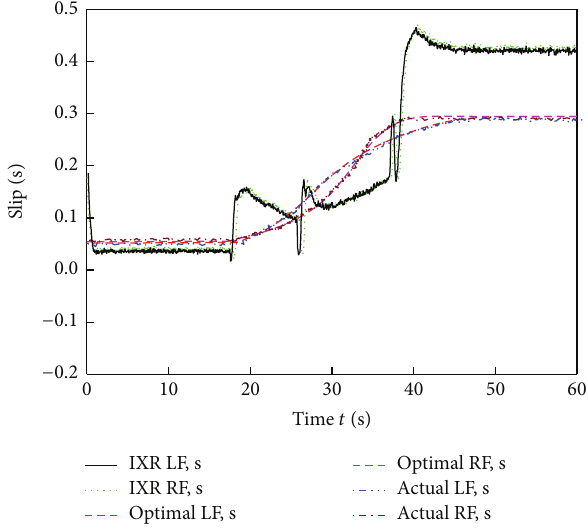
Figure 12: Behind-wheels slip ratio comparison of different control